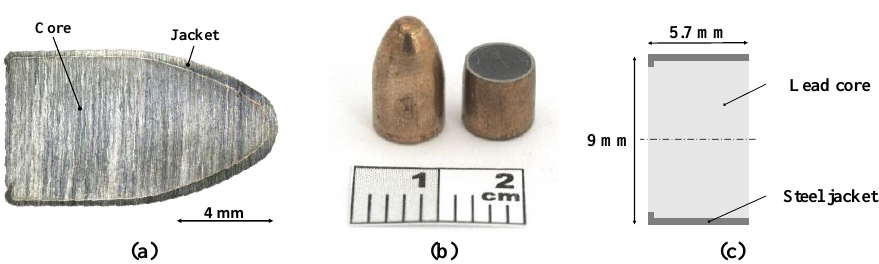
Fig 1. (a) Longitudinal section of the ammunition, (b) ammunition and sample obtained after machining, (c) schematic depiction of the